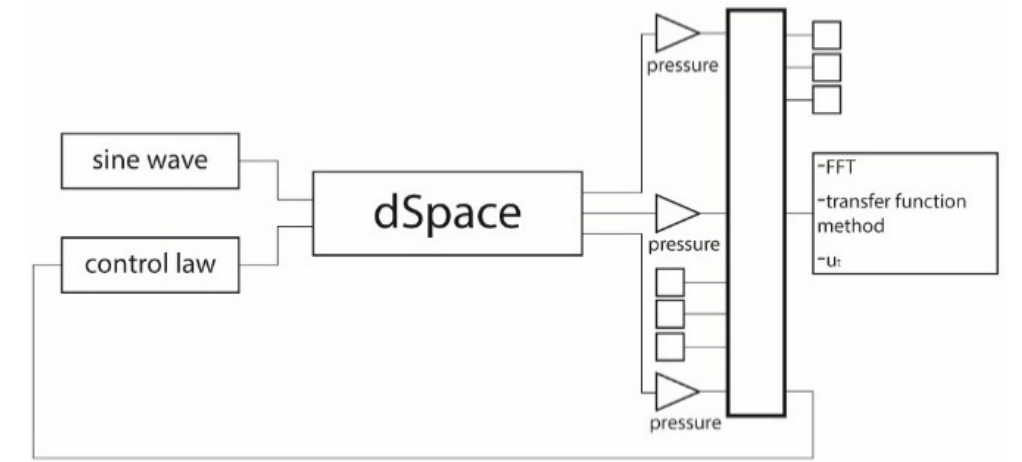
Figure 11. Simulink model for the active case.